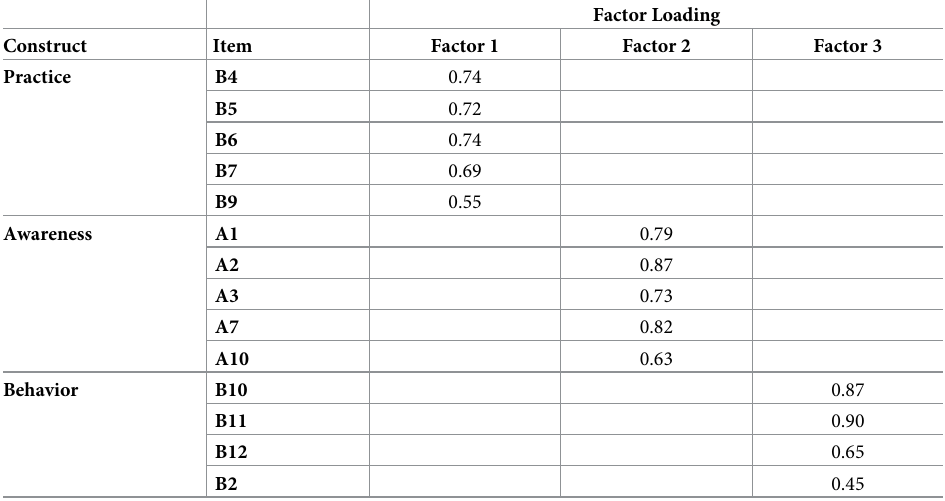
Table 4. Results of exploratory factor analysis for awareness, practice and behavior construct (n:154).